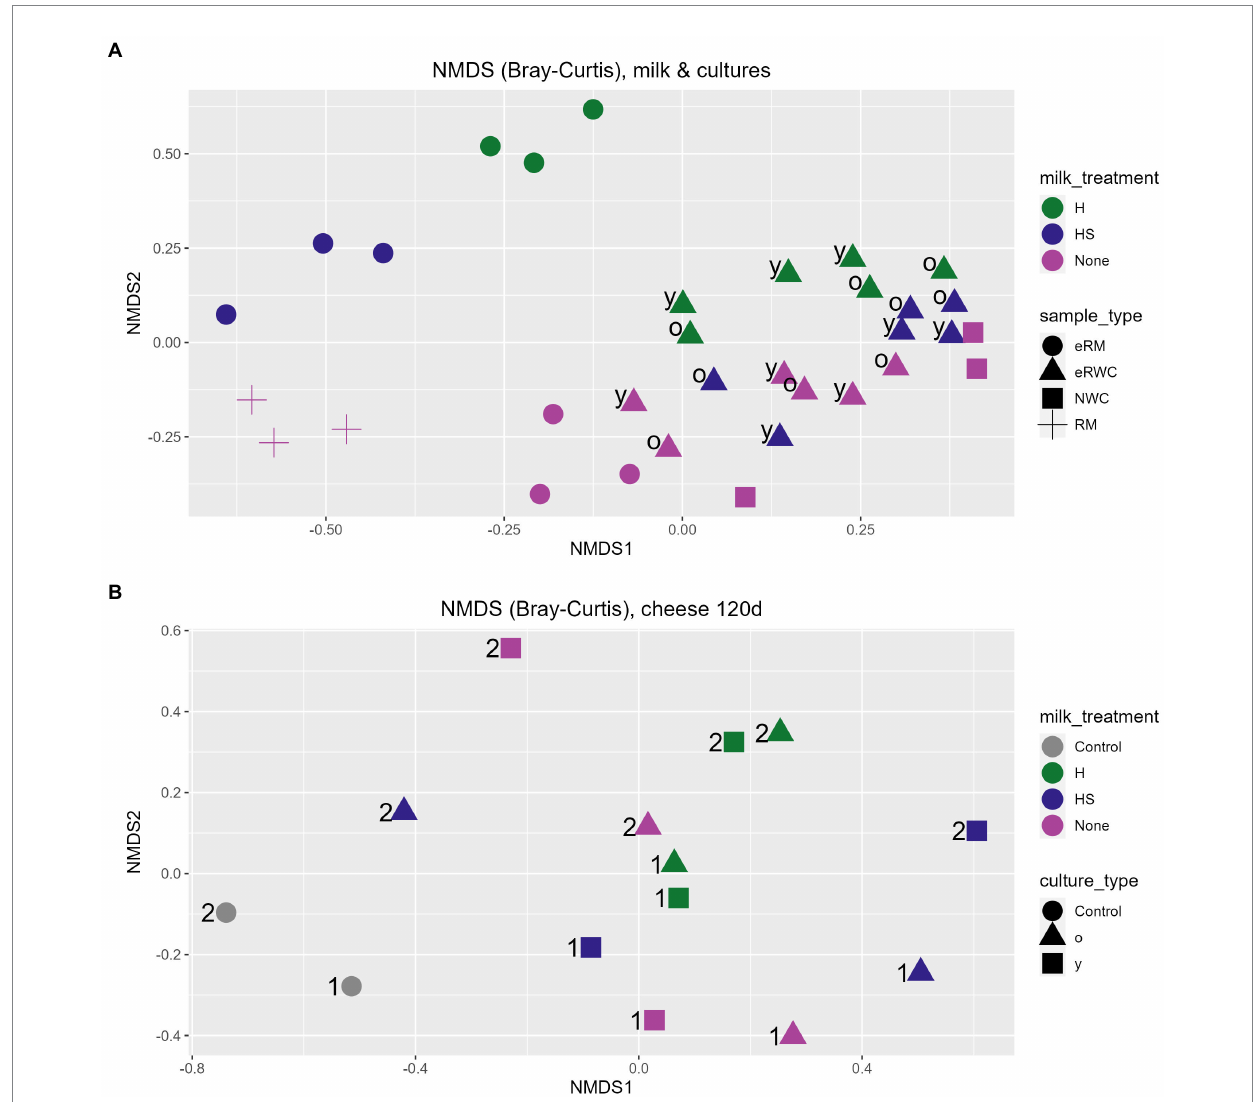
FIGURE 3 NGS results: ordination plot of non-metric multidimension scaling (NMDS) on Bray–Curtis dissimilarities. (A) RM, eRMs, NWC, and eRWCs.; “y” = young, “o” = old. (B) 120 d ripened cheese; “1” = production day 1; “2” = production day 2. Refer to Figure 1 for samples’